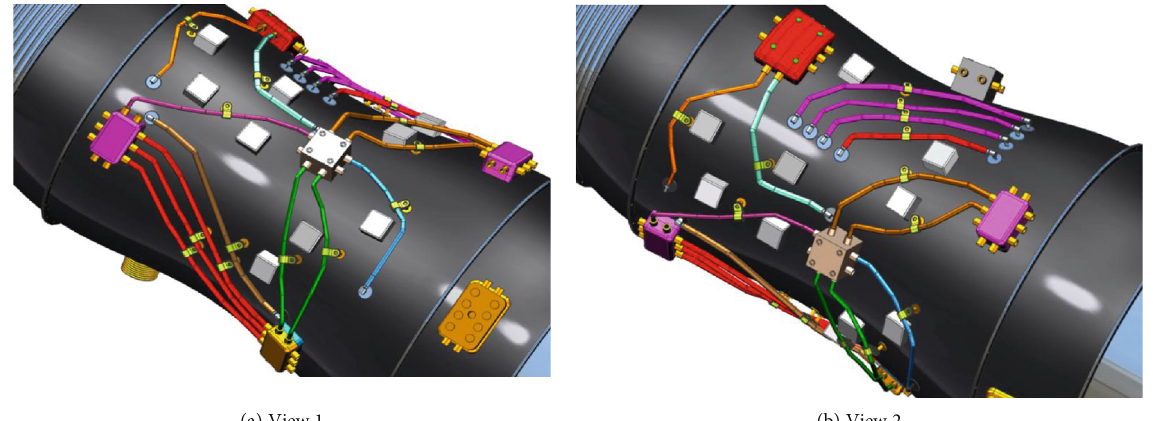
Figure 11: Visualization of multipipes routing